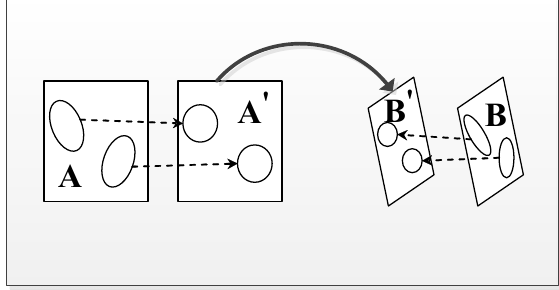
Fig.3 Transformation between a pair of correspondent local Fig.5 shows the proposed method composed of three steps: (1) areas region detection and extraction; (2) region transformation; (3) feature extraction and image